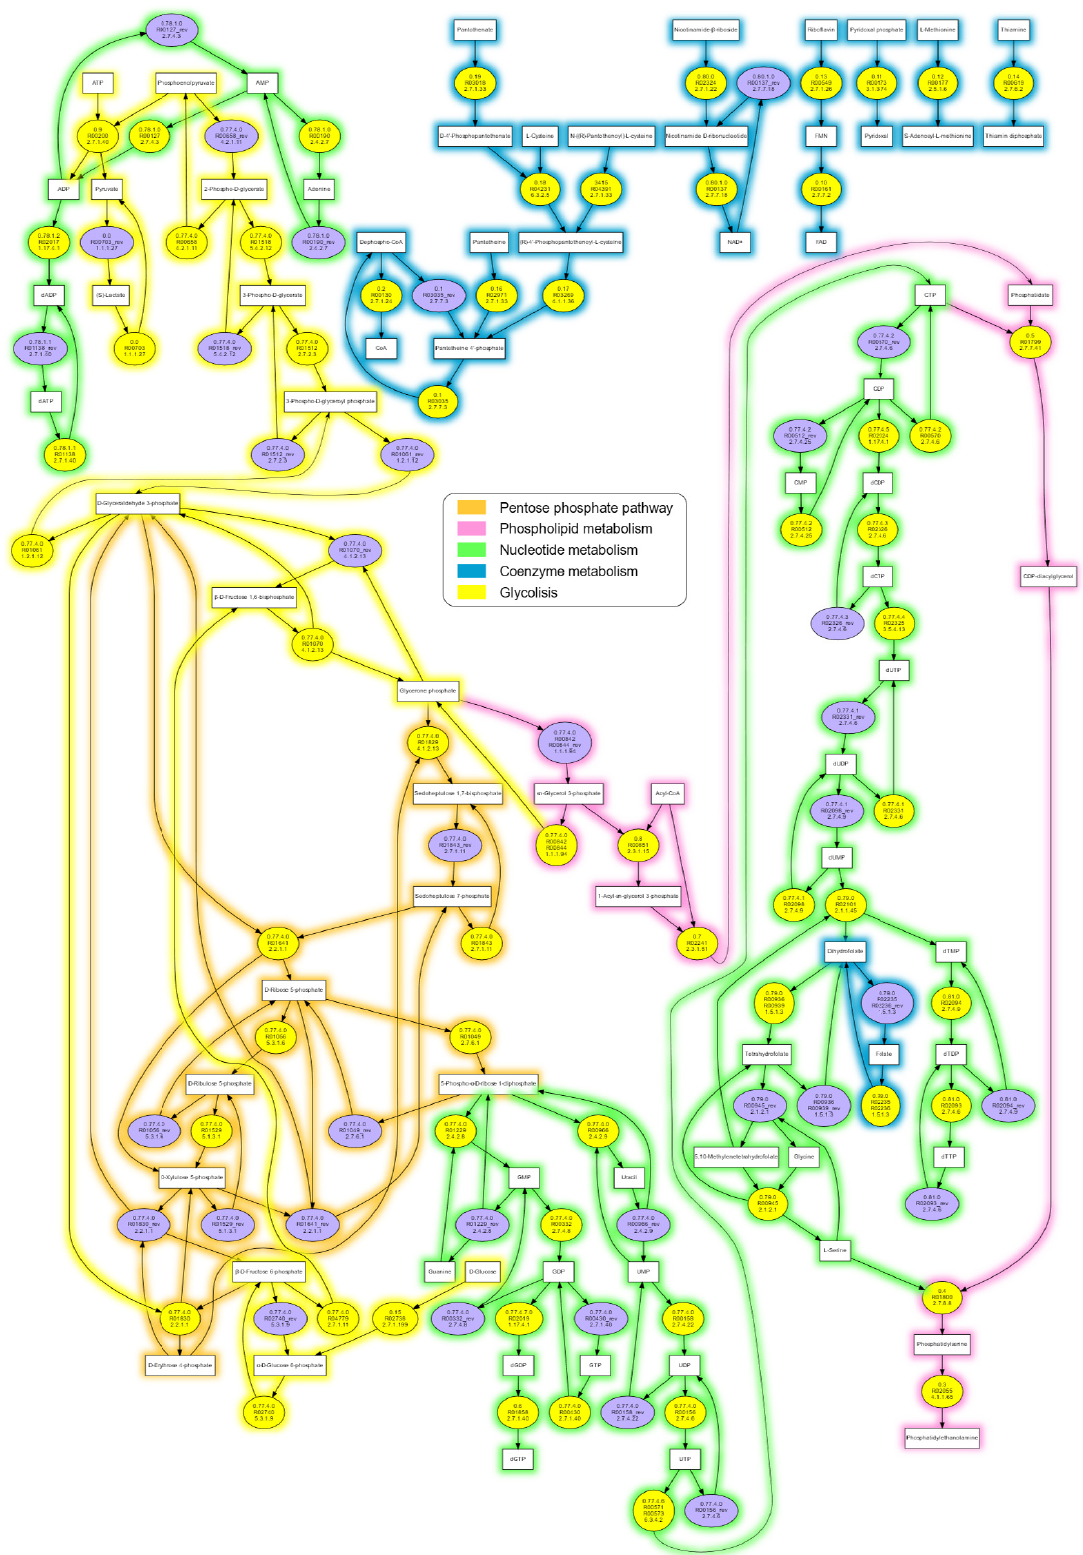
Figure 2. The reaction graph of the proposed theoretical minimal metabolic network represented in Figure 1, obtained us- ing data from the KEGG database. The yellow filled circles are the reactions with their KEGG ID and E.C. numbers, and the purple filled circles are the reverse reaction of the yellow filled circles, when appropriate. Line colors denote metabolic categories. A full-size representation can be seen as Figure